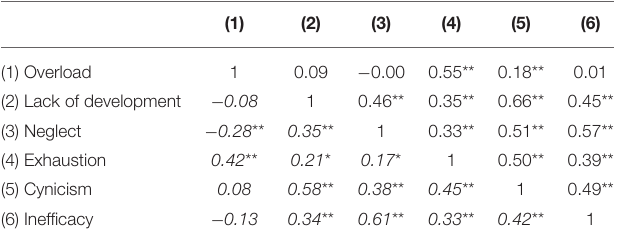
TABLE 3 | Pearson correlations between the German BCSQ-12-SS and